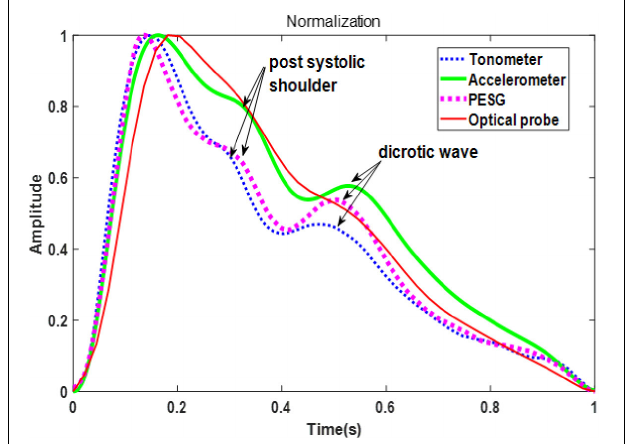
FIGURE 5 | Comparison of the normalized waveforms from each